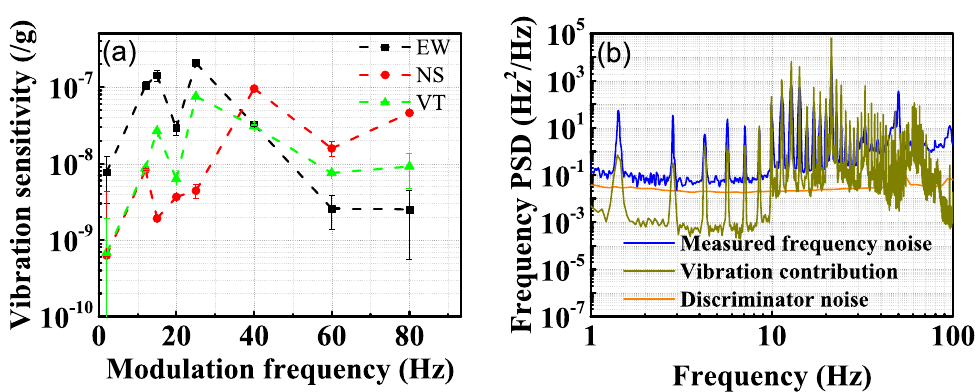
Figure 6. ( a ) Measured vibrational sensitivities for three directions as a function of the excitation frequency. The error bar is enlarged 20 times for viewing purposes. ( b ) The measured frequency noise is shown with the blue curve and the total vibrational noise contribution is shown with the dark yellow curve, which are the measurements of vibrations using the geophones combined with the calibrated vibrational sensitivity of the